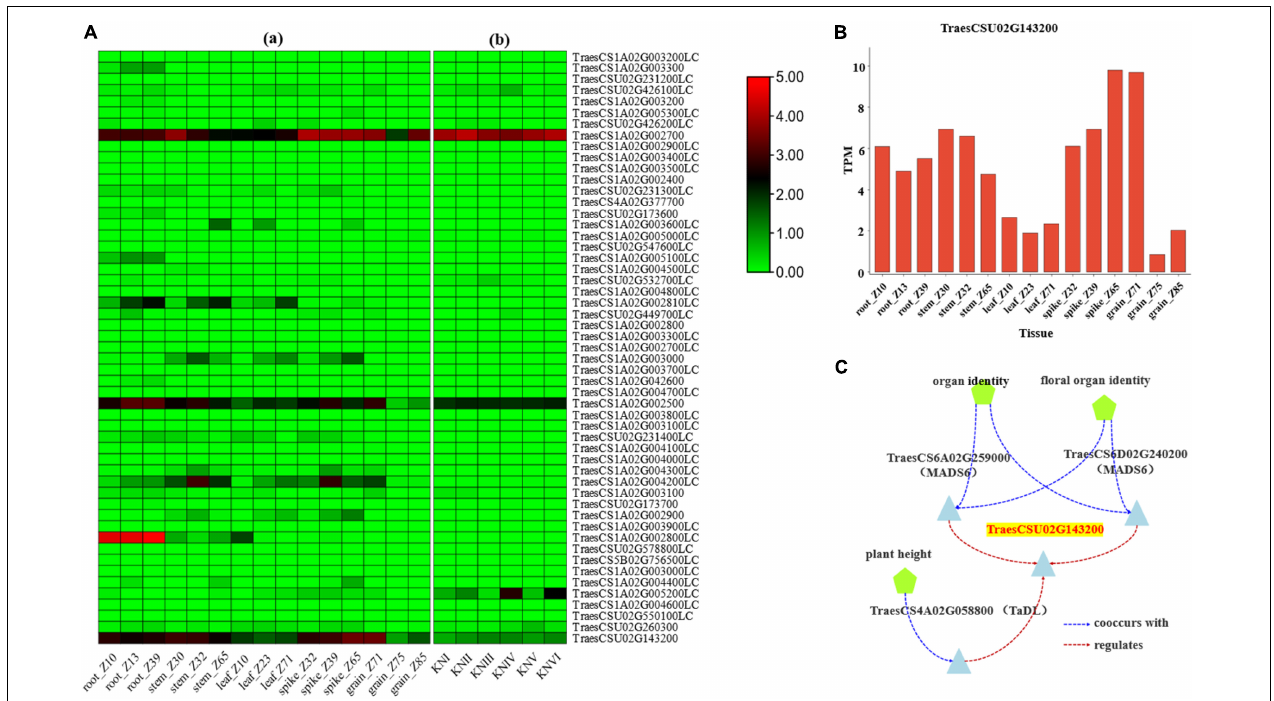
FIGURE 3 | Expression data for candidate genes. (A) The expression pattern of the candidate genes in different tissues and developmental stages: [ (A) a] refers to the expression data from IWGSC (2014), [ (A) b] refers to the expression data from Li et al. (2018), and KNI-KNVI represent the spikes in different developmental stages. (B) The expression of TraesCSU02G143200 gene in different tissues of wheat from the data of IWGSC (2014). (C) The co-expression data of TraesCSU02G143200 from knetMiner